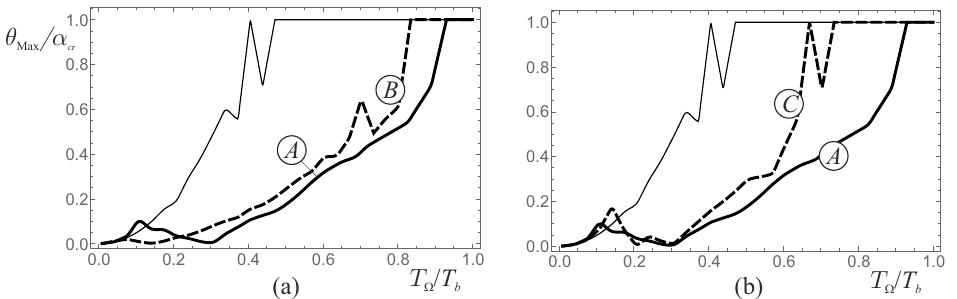
Figure 9. Frequency–response curves of the coupled systems (thick lines) and stand-alone rigid blocks (thin lines): ( a ) curves evaluated for coupled systems defined by points A , B , and C of Figure 8b; ( b ) curves evaluated for coupled systems defined by points A and D of Figure 8b. Dimensions of the rigid block: 2 b = 1.2 m and λ = 6 ( r = 0.9595, u y = 1/3 u cr , m = 0.05 M , ψ =